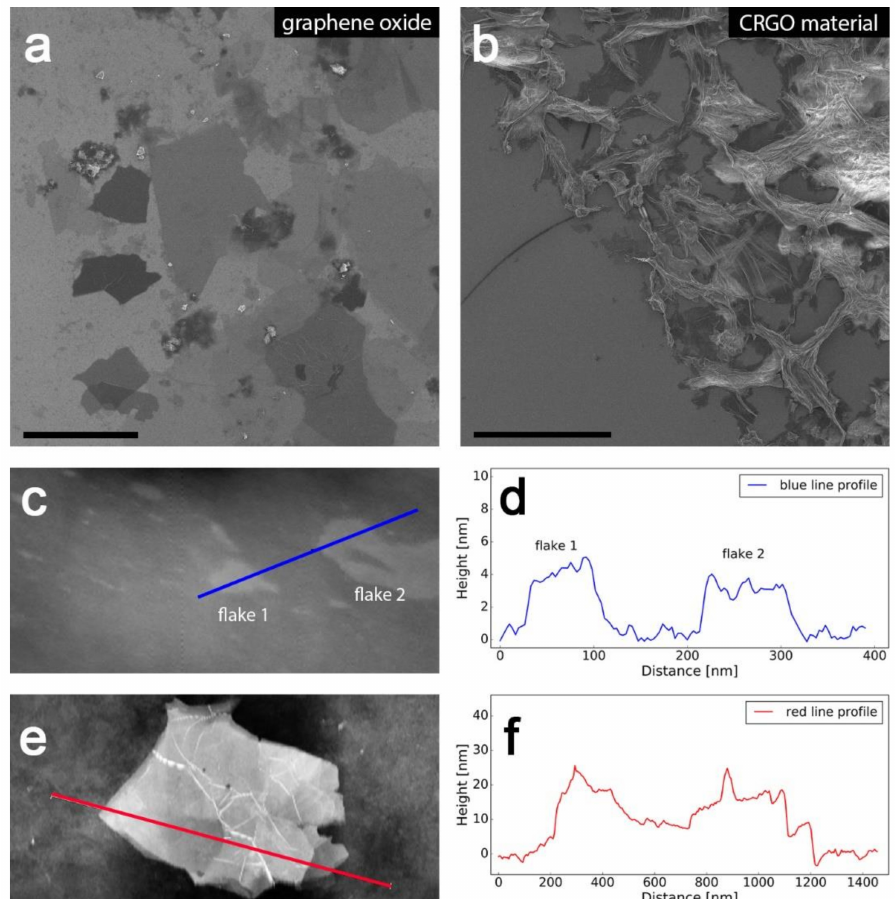
Figure 2. Microscale investigation of graphene materials. ( a ) Scanning electron microscope (SEM) imagesofgrapheneoxide( b )finalcarboxylderivativealongwithAFMimages, and( c )thecorresponding height profiles of CRGO ( c – f ). Scale bars in panels ( a , b ) correspond to 10 µ